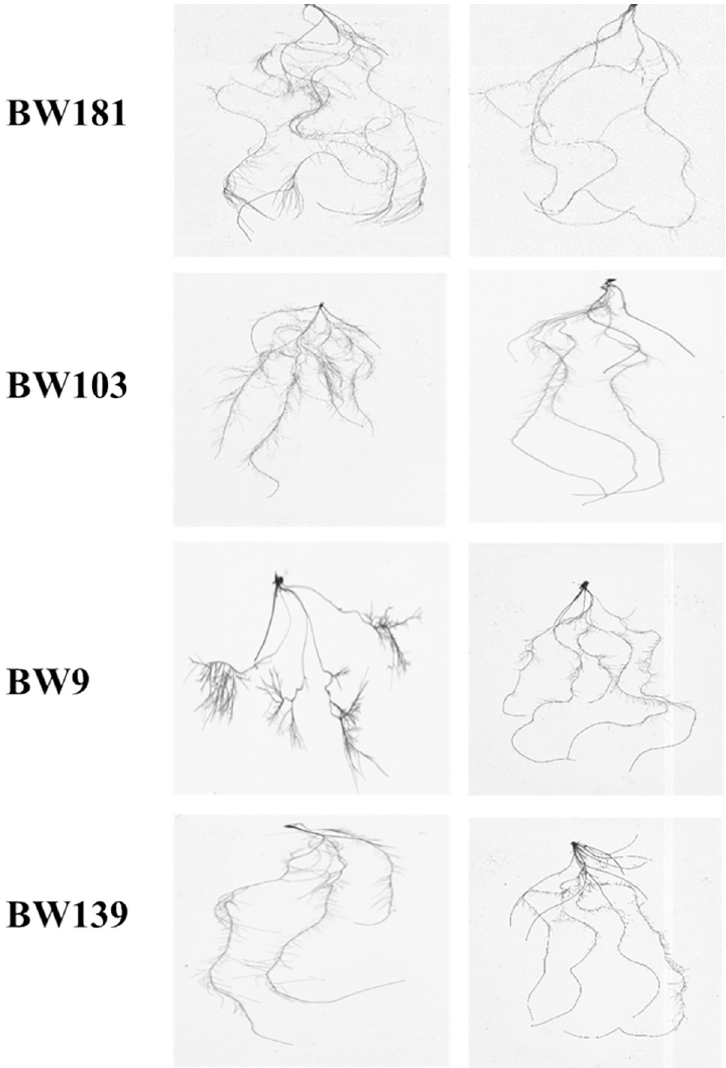
Fig 5. Root system architecture of better performing (BW 181 and BW 103) and poor performing (BW 9 and BE 139) genotypes grown under non-limiting (NLP) and limiting (LP) phosphorus conditions.